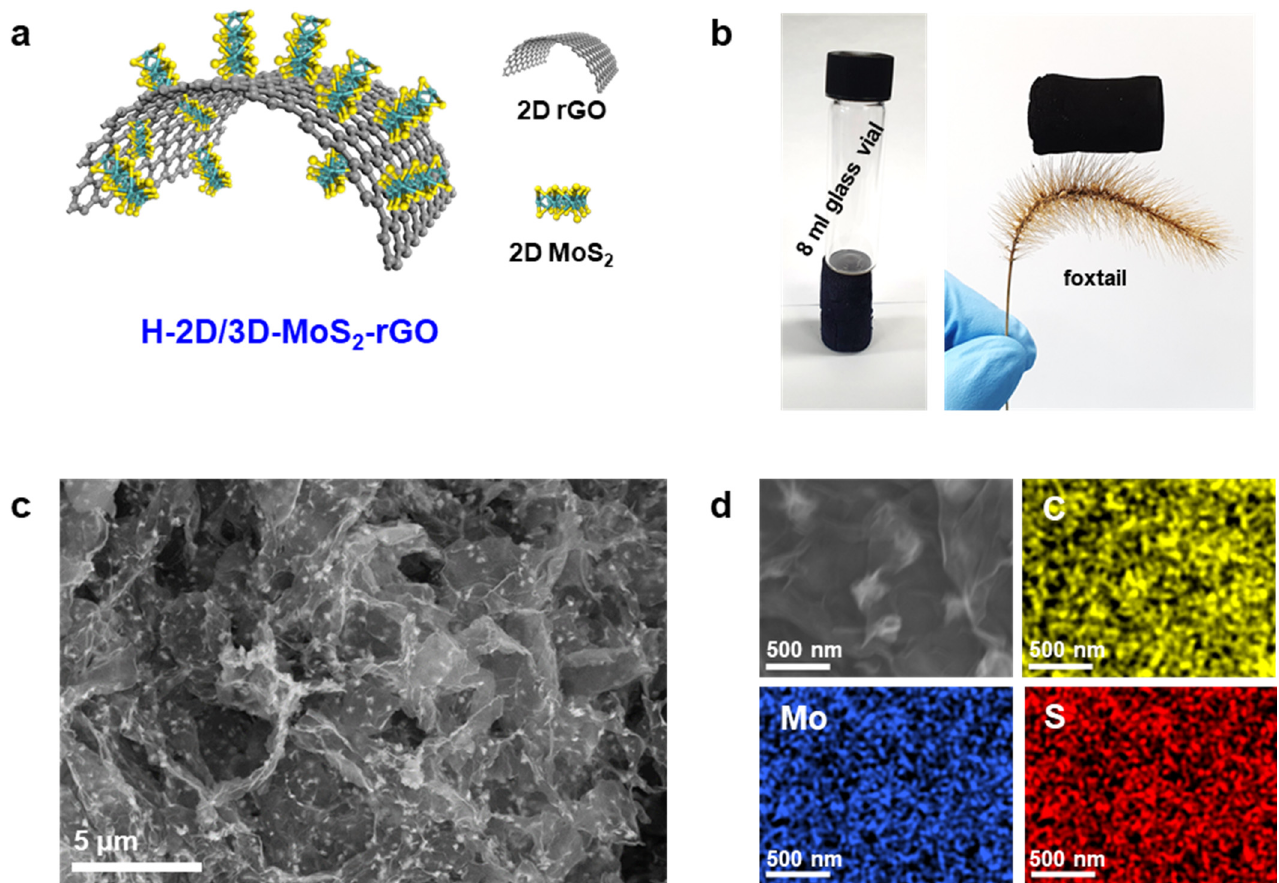
Figure 2. ( a ) Illustration of the 2D/2D assembled 3D porous network architectures. ( b ) Photographic image of H-2D/3D- MoS 2 -rGO supporting the 8-mL glass vial and placed on the foxtail. ( c ) SEM image of H-2D/3D-MoS 2 -rGO. ( d ) SEM and EDX elemental mapping images of H-2D/3D-MoS 2 -rGO.